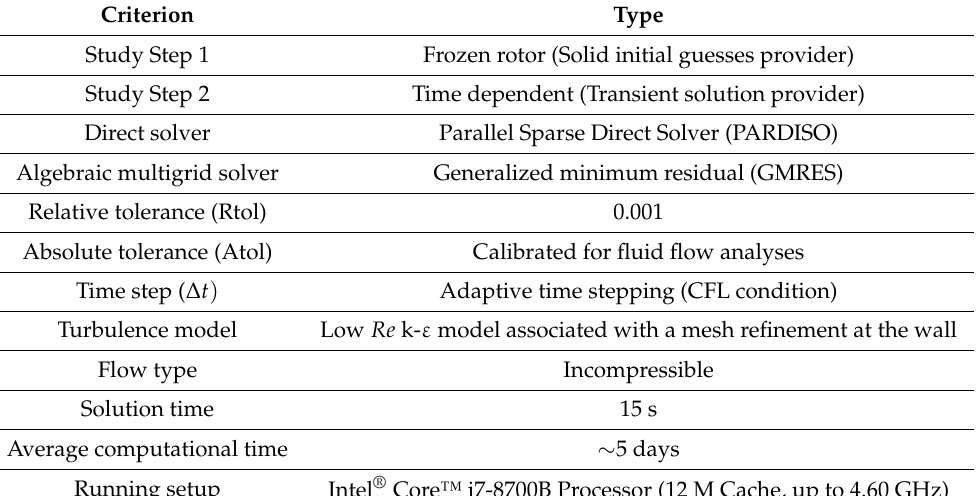
Table 3. 3D solver